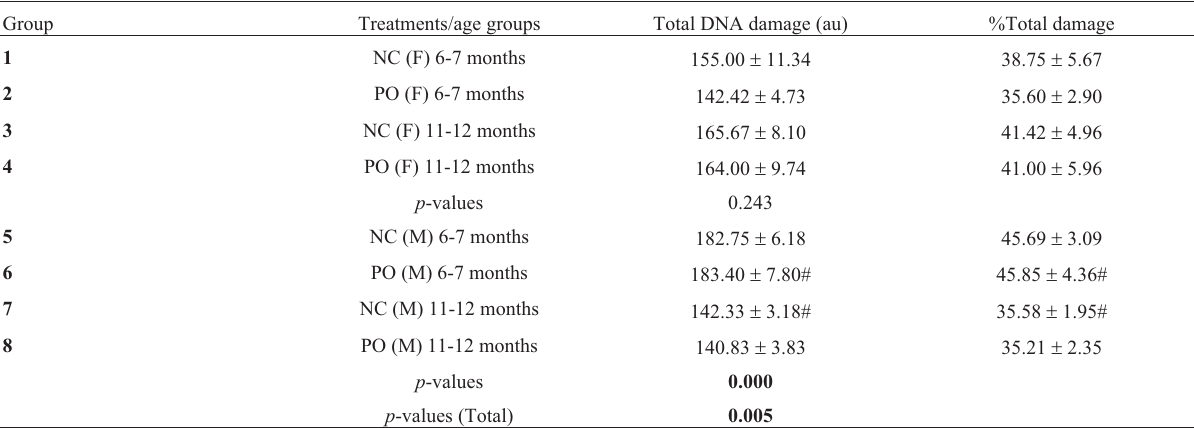
Table 6 - Results of Comet assay (total DNA damage and the correspondent % total damage) obtained from the peripheral blood samples of elderly fe- male (F) and male (M) Swiss albino mice after treatment with pequi oil (30 mg/animal/day) administered orally for 15 consecutive days. Negative con- trols (NC) received filtered water administered in the same way.